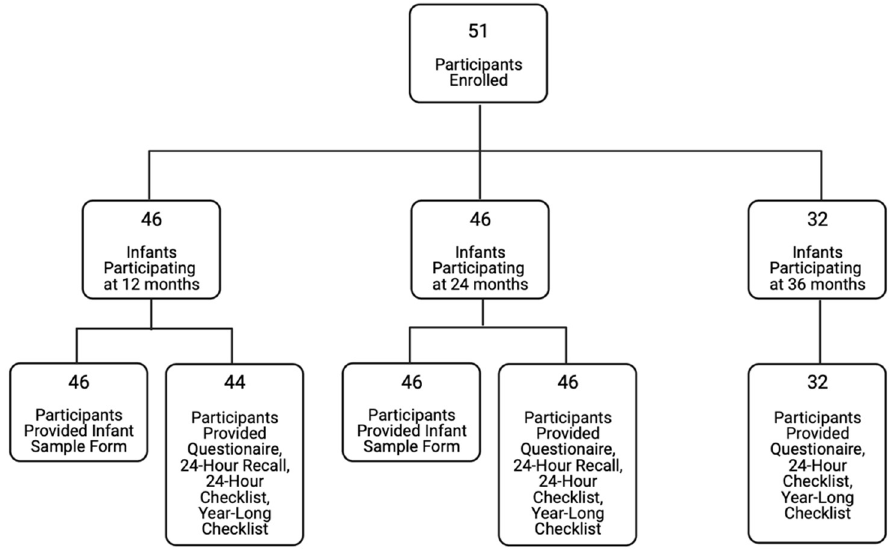
Figure 1. Participant flow chart.